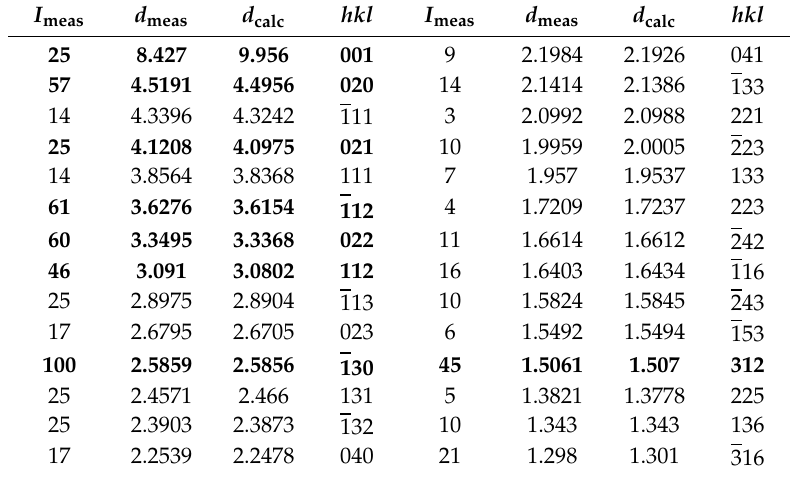
Table 2. X-ray powder di ff raction data ( d in Å) for fluorluanshiweiite (8 strongest lines are in bold).